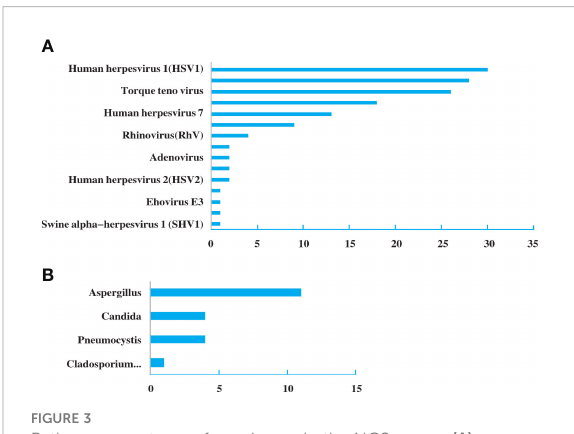
FIGURE 3 Pathogen spectrum of specimens in the NGS group. (A) . Bacterial spectrum. (B) . Fungal